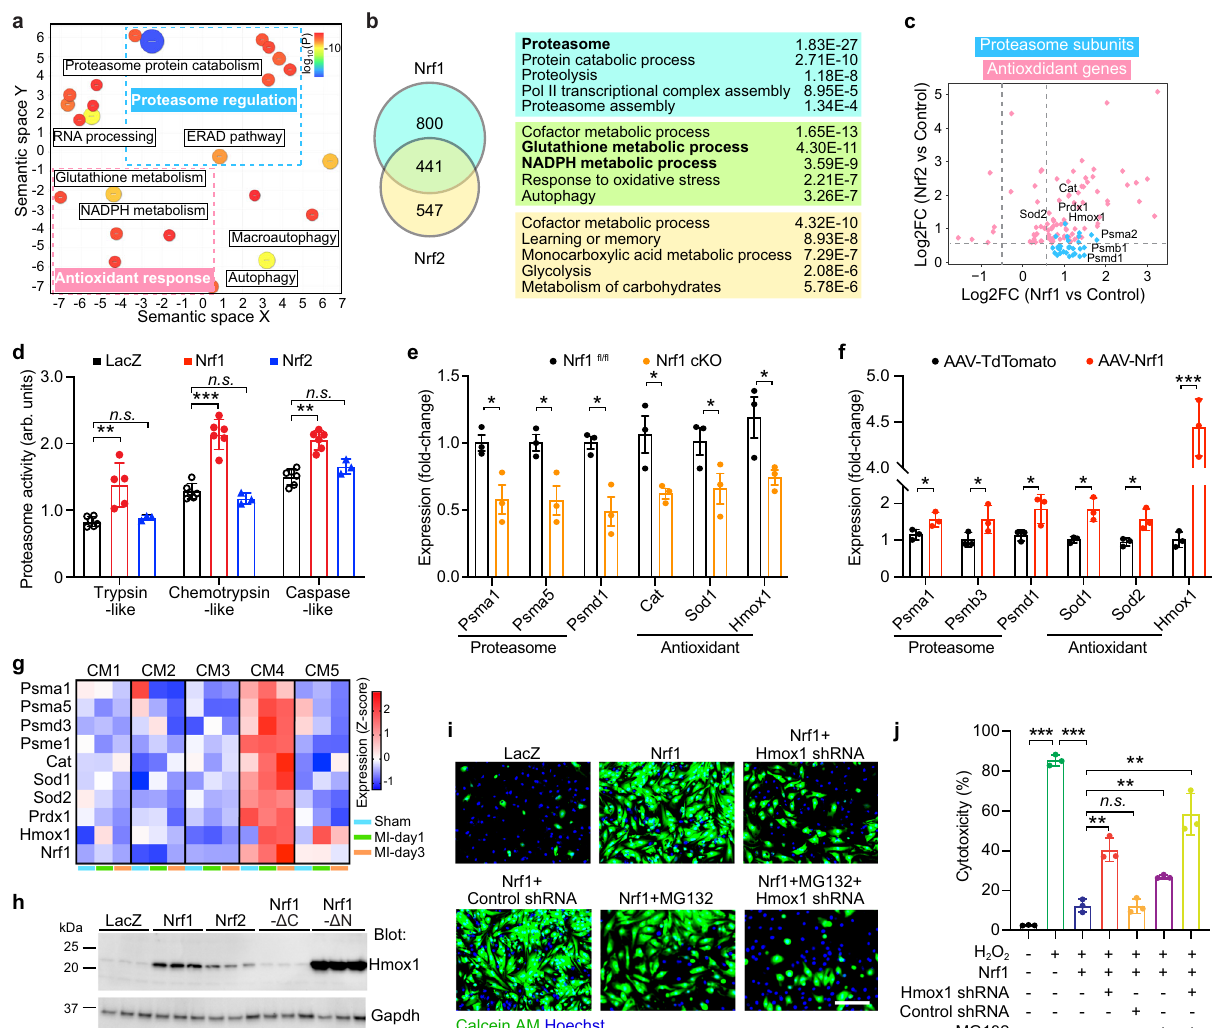
Fig. 4 Nrf1 confers protection by regulating the proteasome and antioxidant response. a Gene ontology analysis of genes upregulated in Nrf1 samples compared to LacZ control samples. Upregulated genes are displayed in semantic space as clusters; the color and proportional size of circles indicate log10 ( P value). P values were obtained using Metascape (see the “ Methods ” section). b Left: Venn diagram showing a number of genes upregulated by Nrf1, Nrf2, or both; Right: top enriched GO terms for each gene group. c Log2 fold-change (FC) of selected proteasome subunit genes (blue) and antioxidant genes (pink) in NRVMs overexpressing Nrf1 ( x -axis) or Nrf2 ( y -axis). d Proteasomal activity in arbitrary units (arb. units) of NRVMs overexpressing LacZ, Nrf1 or Nrf2; n = 6 biologically independent experiments for groups LacZ and Nrf1; n = 3 biologically independent experiments for group Nrf2; Trypsin-like, ** p = 0.0030; Chemotrypsin-like, *** p = 0.000009; Caspase-like, ** p = 0.000031. e qPCR measurement of proteasome subunit genes and antioxidant genes in Nrf1 cKO and control hearts at P14; n = 3 for each group. Psma1 , * p = 0.0266; Psma5 , * p = 0.0261; Psmd1 , * p = 0.0120; Cat , * p = 0.0364; Sod1 ,* p = 0.0462, Hmox1 , * p = 0.0510. f qPCR measurement of proteasome subunit genes and antioxidant genes in AAV-Nrf1 and AAV-TdTomato hearts from 2-month-old mice; n = 3 for each group. Psma1 , * p = 0.0459; Psmb3 , * p = 0.0426; Psmd1 , * p = 0.0507; Sod1 , * p = 0.0128; Sod2 , * p = 0.0268, Hmox1 , *** p = 0.0001. g Expression of proteasome subunit genes and antioxidant genes in CM1 – CM5 cells from our previous snRNA-seq data (GSE130699). Expression levels in z -scores from 1-day post-Sham (Sham), 1-day post-MI (MI-day1), and 3-day post-MI (MI-day3) samples were plotted. h Western blot showing Hmox1 expression in NRVMs overexpressing LacZ, Nrf1, Nrf2, Nrf1- Δ N, or Nrf1- Δ C. i , j Viable cells ( i , green) and percent of cell death ( j ) in NRVMs overexpressing Nrf1 plus Hmox1 shRNA, or MG132 treatment, or both, following H 2 O 2 treatment; n = 3 biologically independent experiments. *** p < 0.0001, ** p = 0.002 (column 3 vs. 4 and column 3 vs. 7), ** p = 0.0018 (column 3 vs. 6). Scale bar, 100 μ m; d , e , f , j results are shown